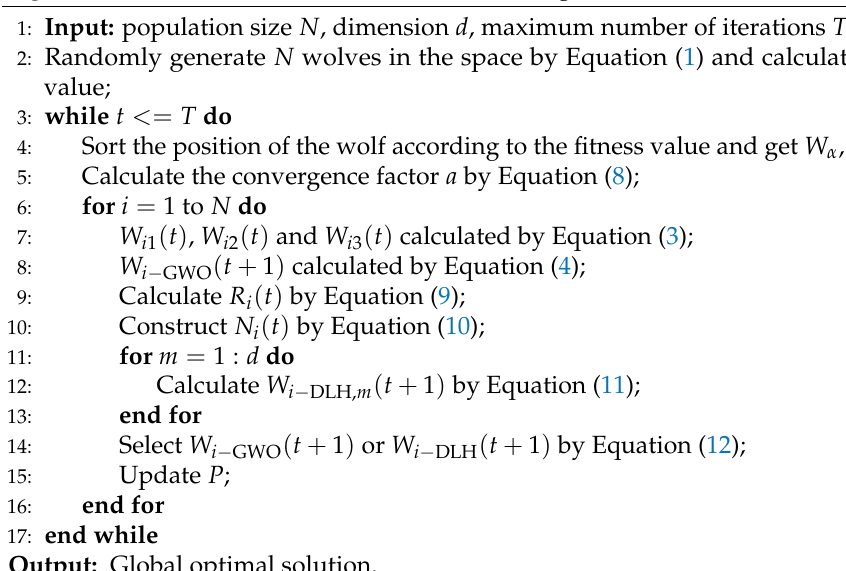
Algorithm 1 Pseudocode of the modified IGWO